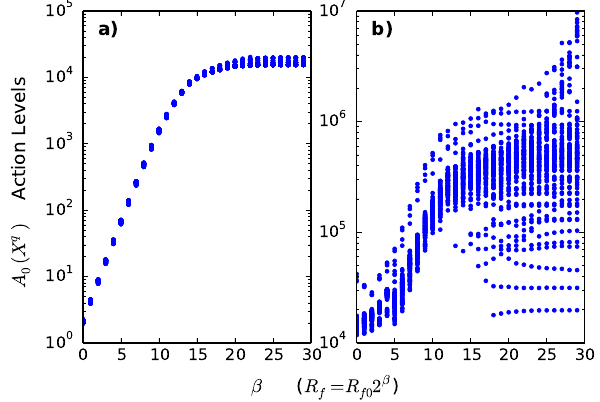
Figure 3. Action levels as a function of R f for the Lorenz96 model, D = 10, R f 0 = 0.01. (a) L = 5 and (b) L = 6 when the wrong data are used for the Lorenz96 model. We actually used data from four realizations of the Lorenz63 model (Lorenz, 1963). The structure of the action levels versus R f shows no trace of the minimum al- lowed level Eq. (6). This indicates that the data and the model are incompatible. The action levels are also quite large, and, for L = 6, numerous and not well